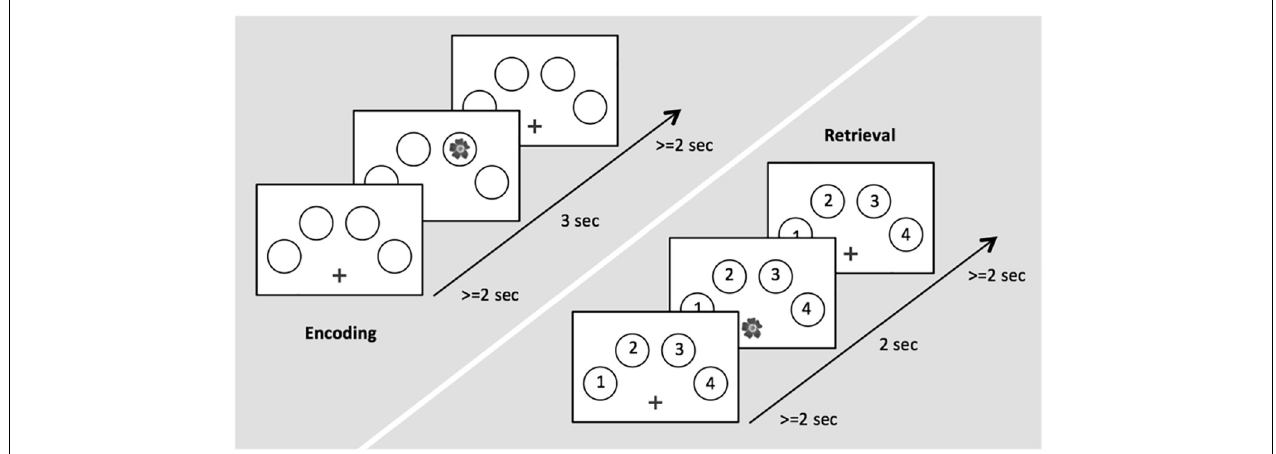
FIGURE 1 | Time course of stimulus presentation for the encoding (left) and the retrieval session (right).